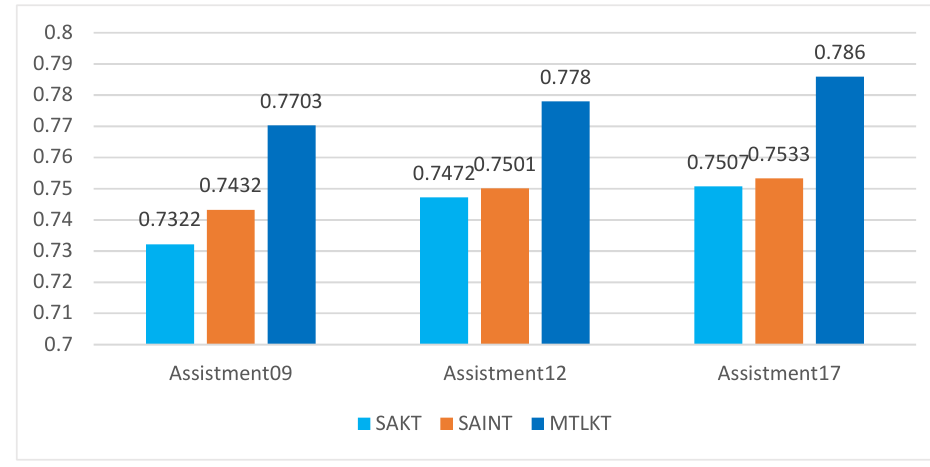
Figure 3. Comparison with attention mechanism model.